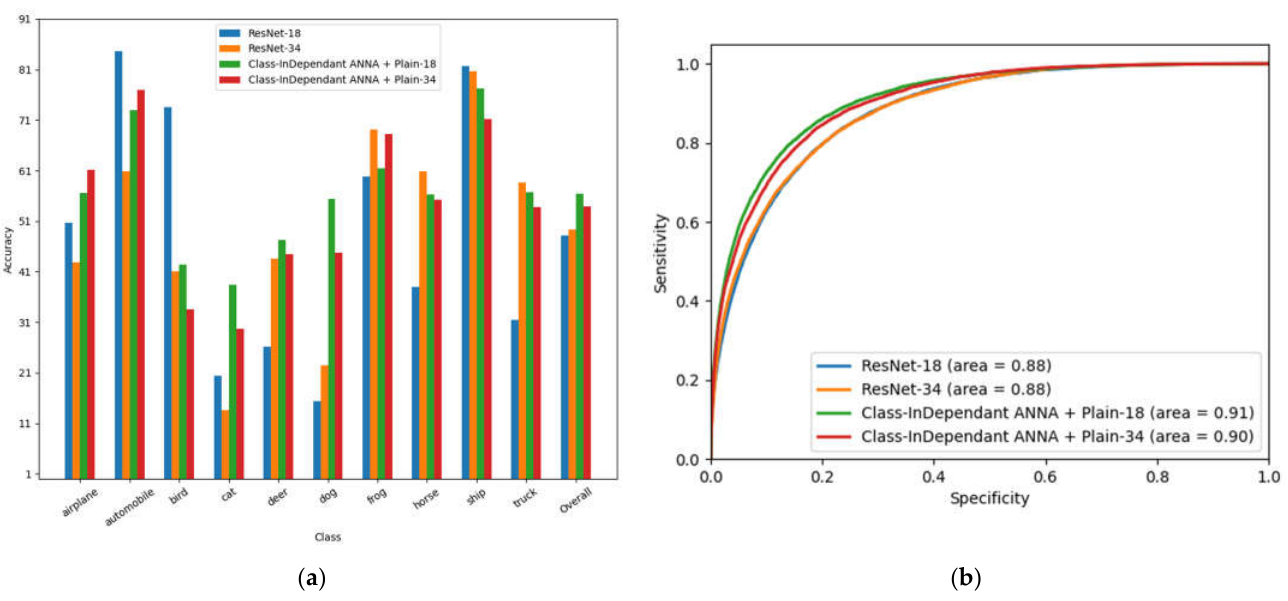
Figure 15. Comparison of ResNet and class-independent ANNA. ( a ) Overall accuracy and per-class accuracies achieved by ResNet and class-independent ANNA on CIFAR-10 dataset; ( b ) ResNet and class-independent ANNA ROC curves on CIFAR-10 dataset.